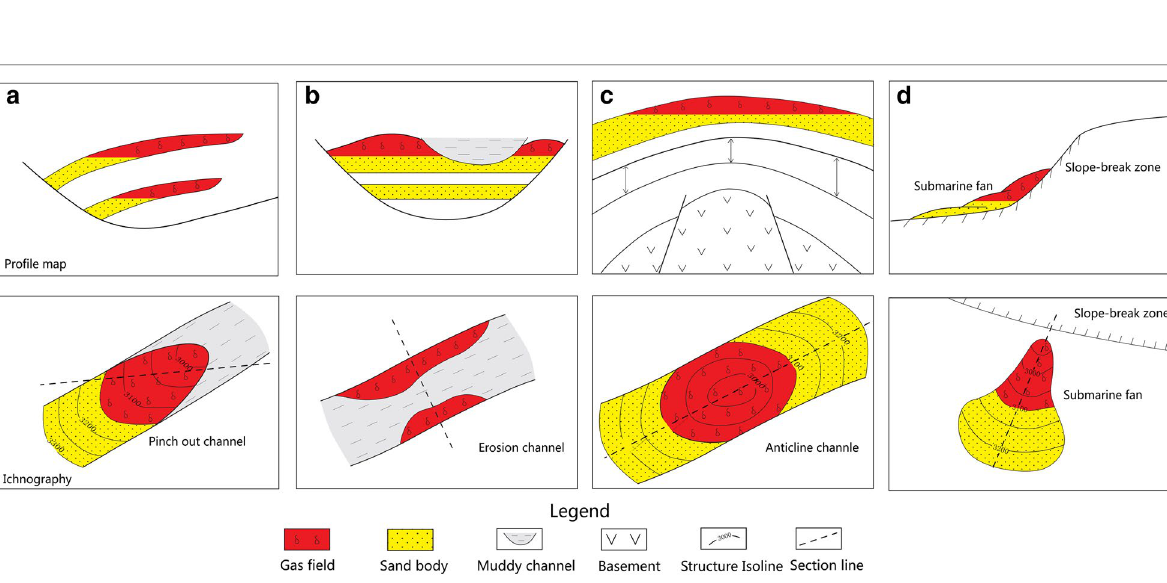
Fig. 8 The types and characteristics of lithology-stratigraphic traps in the Ledong and Lingshui sags, Qiongdongnan